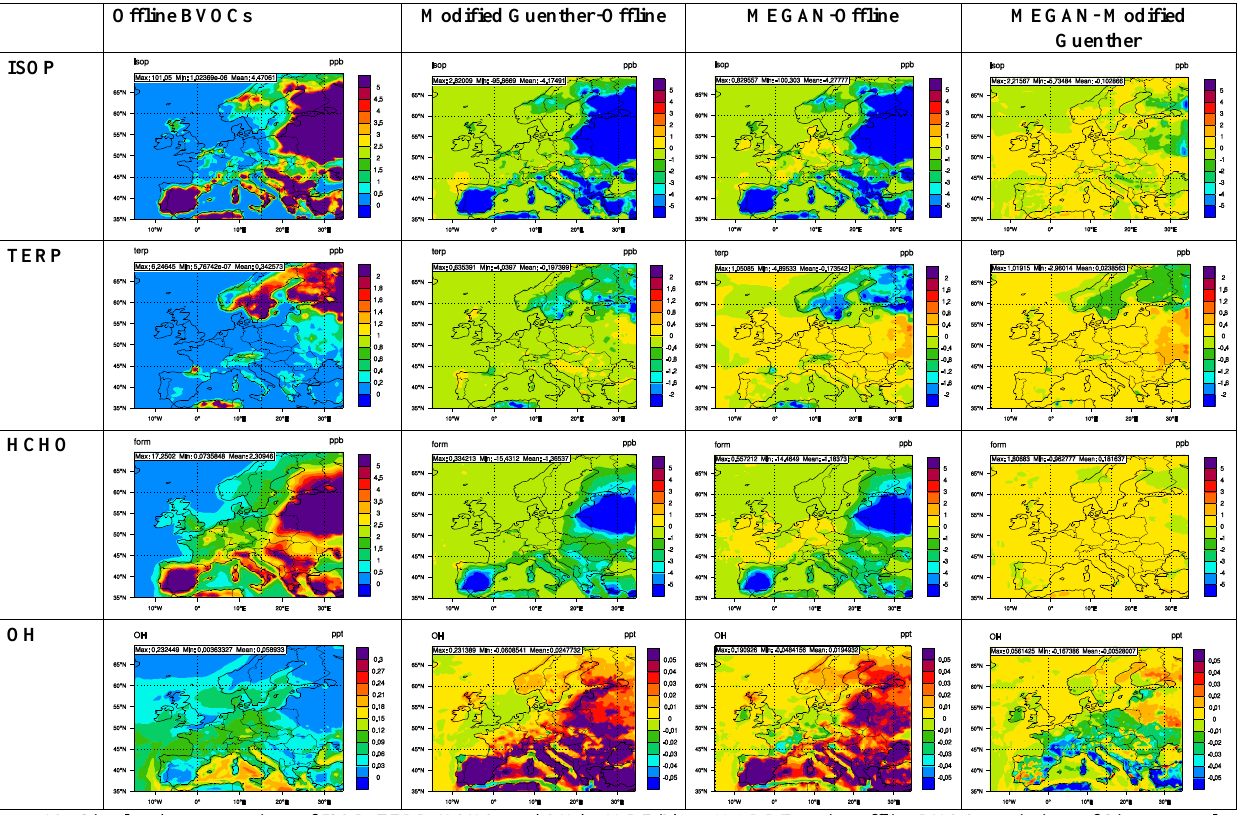
Figure 10. Simulated concentrations of ISOP, TERP, HCHO, and OH by WRF/Chem-MADRID using offline BVOCs emissions of Simpson et al. (1999) (Column 1) and the absolute differences in their concentrations between simulations with modified Guenther online module and offline emissions (Column 2), between simulations with MEGAN2 online module and offline emissions (Column 3), and between simulations with MEGAN2 and modified Guenther online modules (Column 4) in July 2001 over D01.